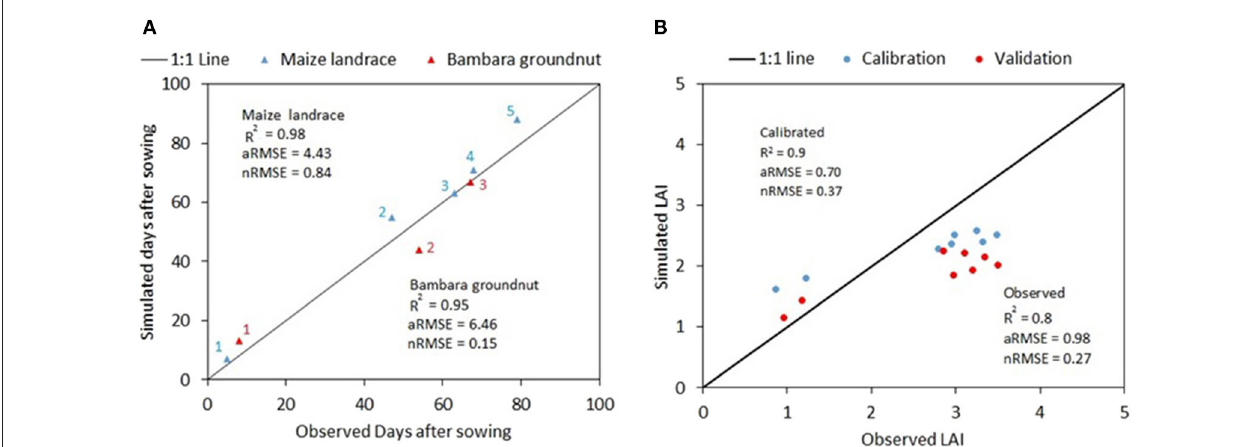
FIGURE 1 | Comparison of observed and simulated (A) phenology (days after sowing) and (B) leaf area index for maize landrace and bambara groundnut during model calibration and validation. Red triangles represent bambara groundnut, and associated numbers 1, 2, and 3 represent phenological stages; emergence, the onset of flowering and start of grain filling respectively. Blue triangles represent maize landrace, and associated numbers 1, 2, 3, 4, and 5 represent phenological stages as emergence, floral initiation, flag leaf formation, the onset of flowering, and start of grain filling respectively.